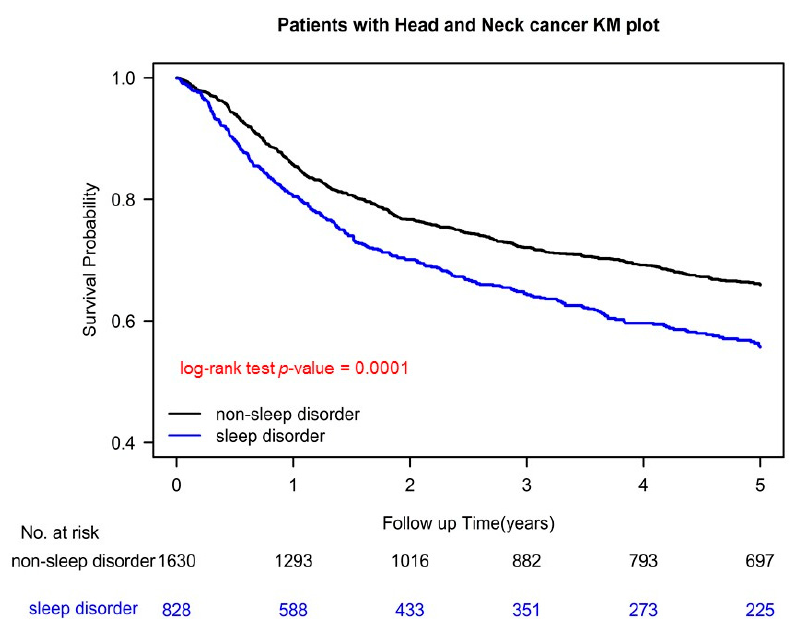
Figure 1. Kaplan–Meier survival curves of propensity-score-matched patients with oral cavity squamous cell carcinoma with and without sleep disorders.